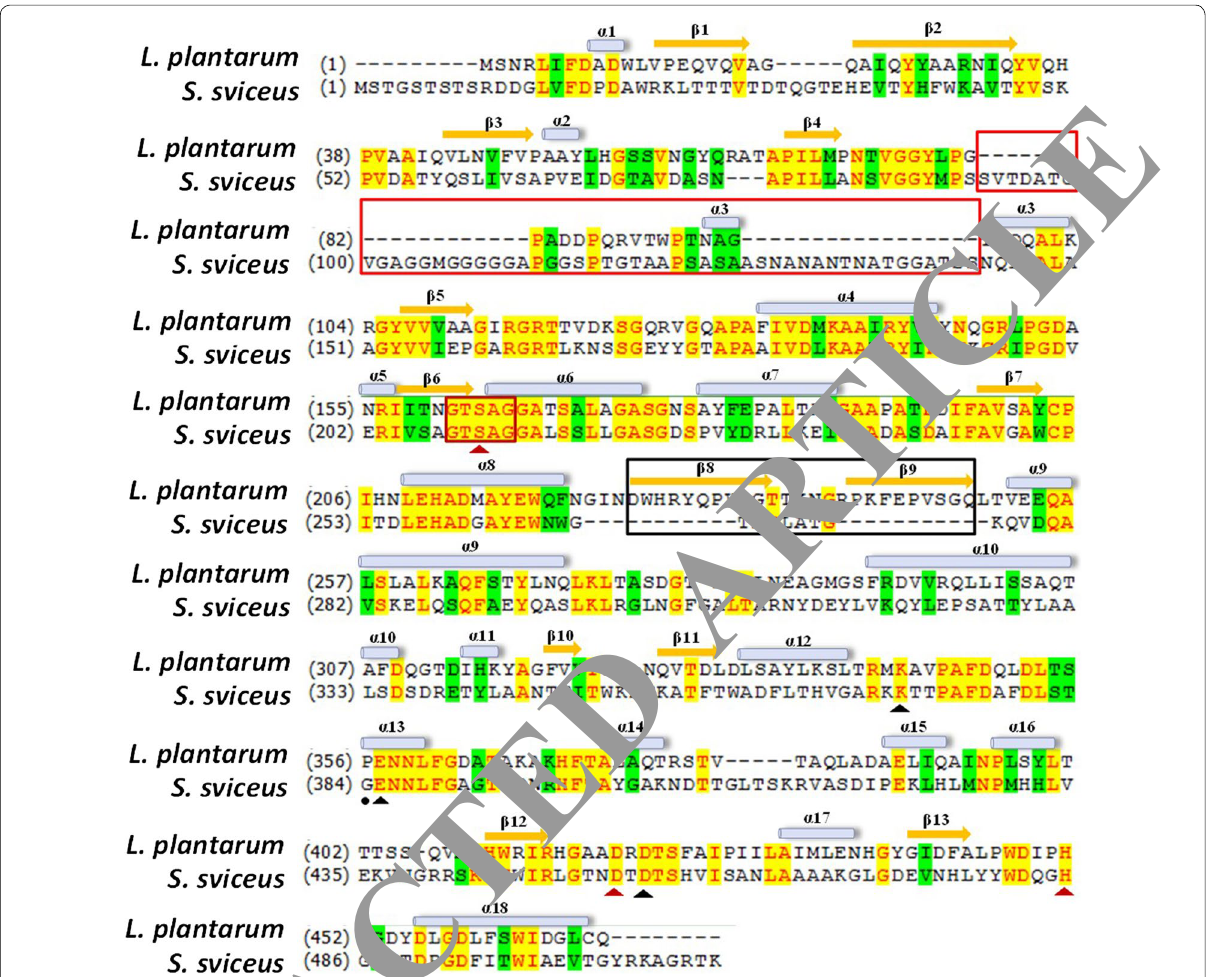
Fig. 1 Amino acid sequence alignment of tannase from L. plantarum and S. sviceus . The secondary structure elements of LP-tan are indicated. The conserved residues of the catalytic triad are indicated by red rectangle. The flap part of LP-tan is indicated by black rectangle. The residues of the catalytic triad are indicated by red triangles and those involved in substrates binging are indicated by black triangles. The flap-like domain of SS-tan is indicated by red rectangle. The black dot indicated the mutation of sandwich